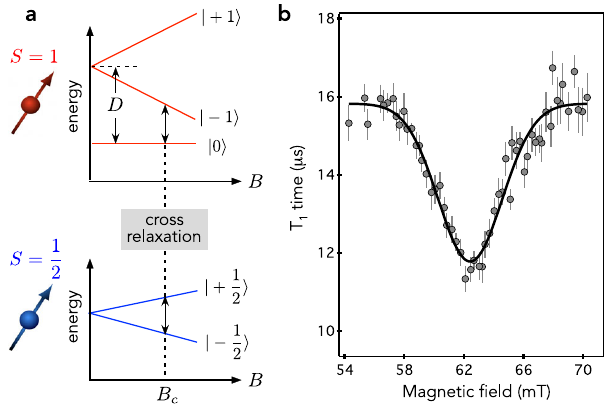
spin triplet Fig. 5 Cross-relaxation spectroscopy. a Energy levels of the V (cid:1) B ground state (top panel) and of a paramagnetic impurity with S = 1/2 (bottom panel) as a function of a static magnetic fi eld B . The two spin systems are brought in resonance for B = B c ~ 62 mT. b T 1 time of the V (cid:1) B spin defect in the h 10 BN crystal as a function of a magnetic fi eld applied along the c -axis. The fi eld amplitude is inferred by recording the Zeeman shift of the ESR frequency of the V (cid:1) defect. The solid line is data fi tting with B a Gaussian function. The error bars correspond to the uncertainty of fi tting the T 1 decay curve with an exponential